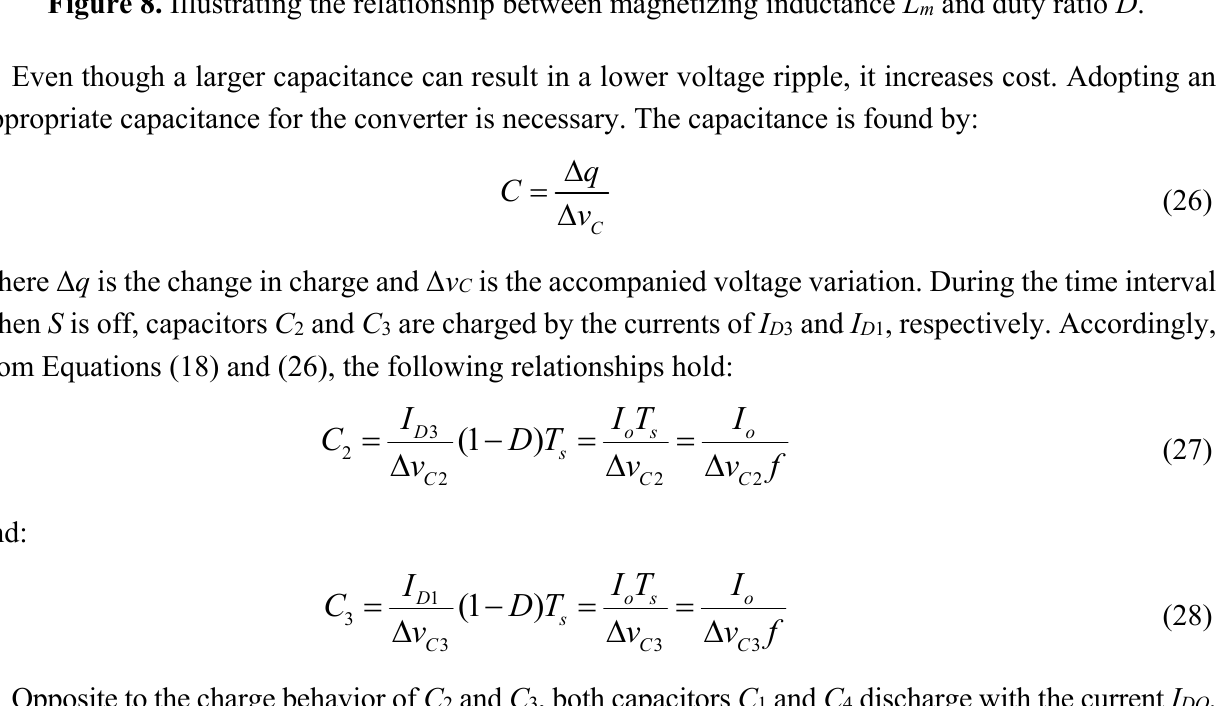
Figure 8. Illustrating the relationship between magnetizing inductance L m and duty ratio D